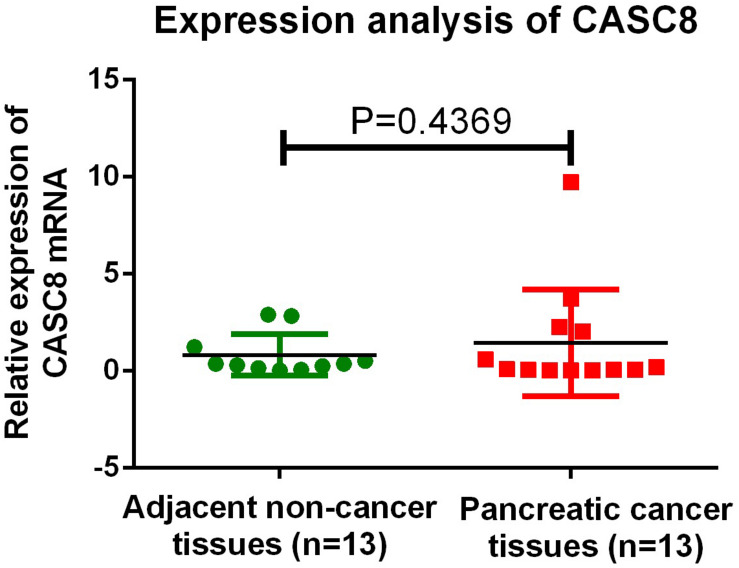
qPCR validation of cancer susceptibility candidate 8 (CASC8) expression in 13 Chinese pancreatic adenocarcinoma (PAAD) patients. Tukey’s multiple comparison test was used to analyze the differences among 13 samples from two groups and to estimate the level of significance.